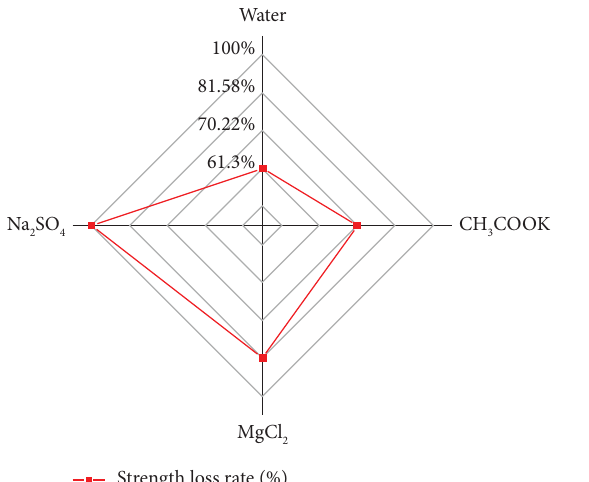
Figure 11: Strength loss rate after the ffth freezing-thawing cycle.